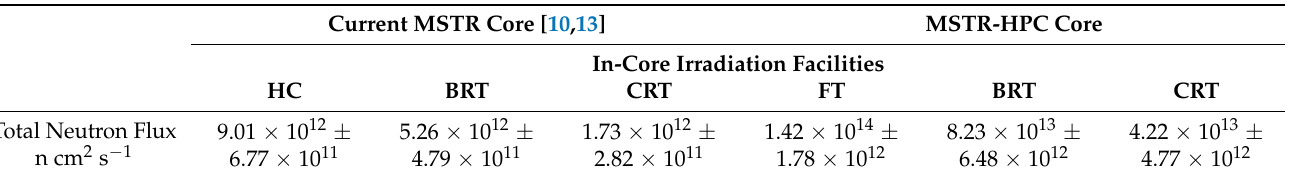
Table 5. Comparison of total neutron flux in-core irradiation facilities for the current MSTR and the MSTR-HPC core configurations.